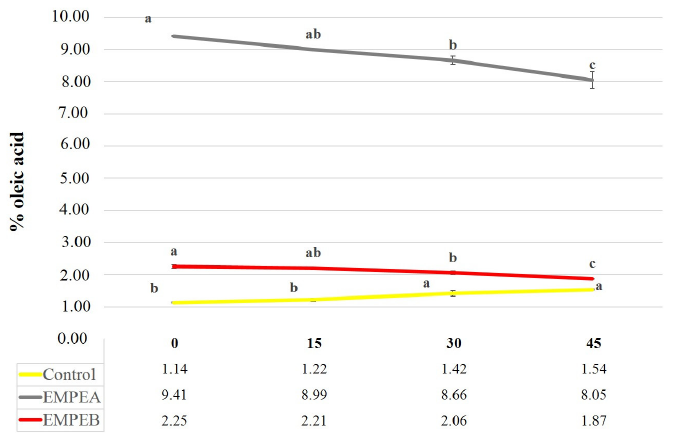
Figure 2. Changes in Total Acidity in the samples during storage time. Different letters show differences for p < 0.05.